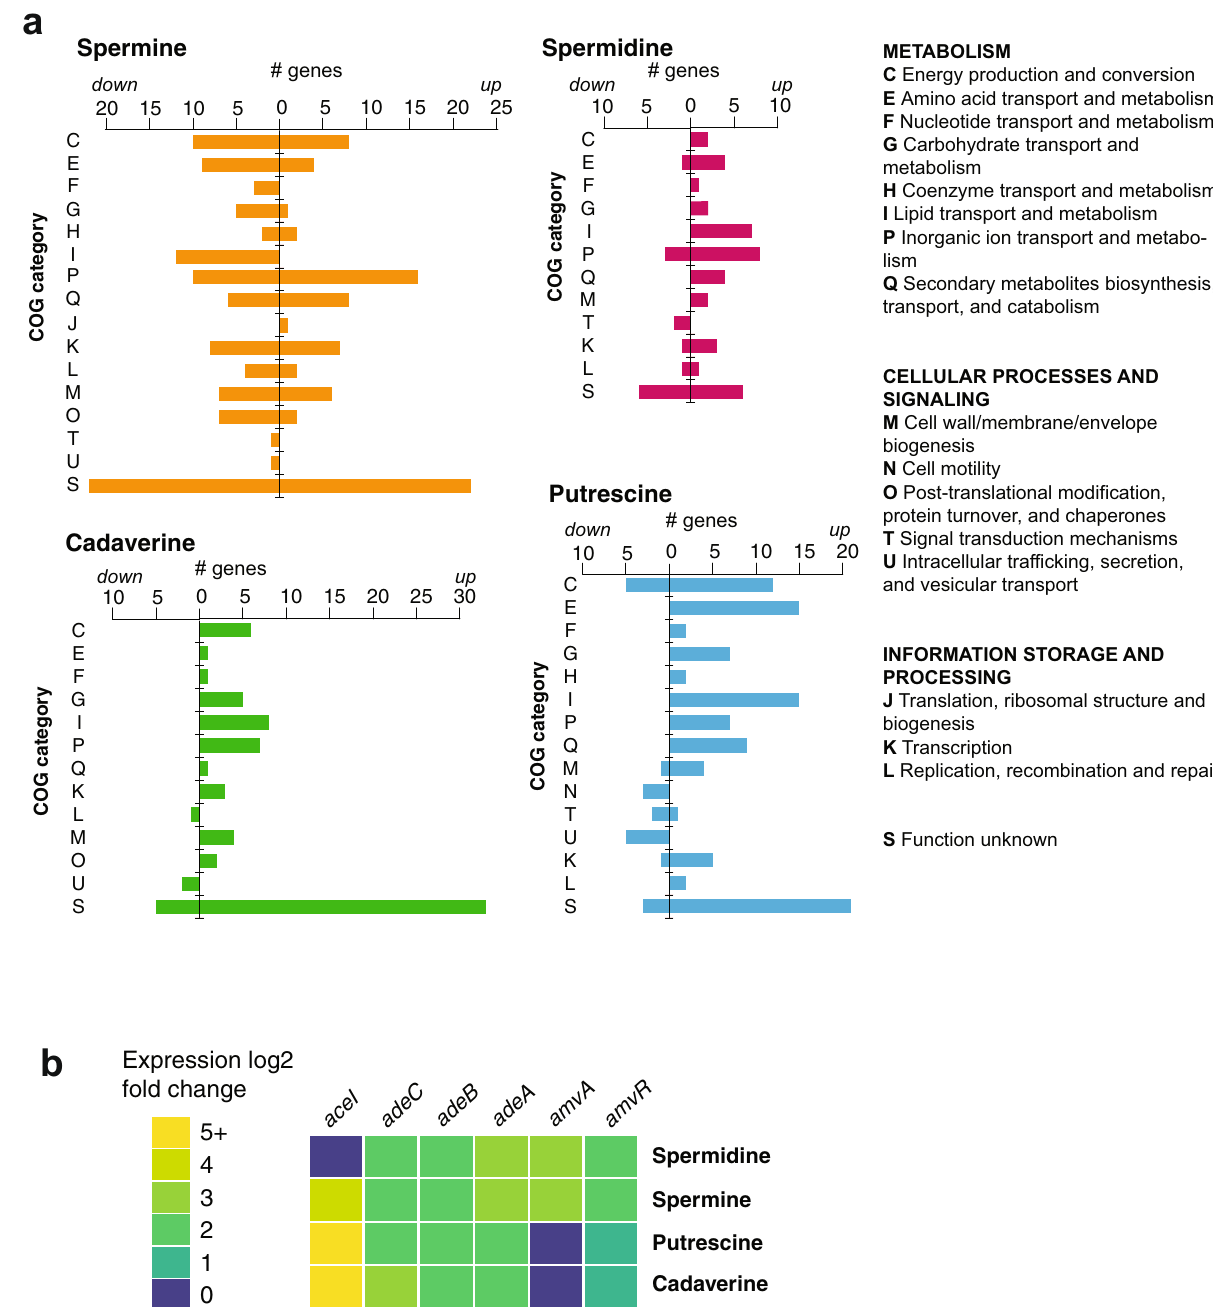
Fig. 2 Polyamine-regulated gene functional categories and phenotypes. a Functional categories of genes regulated by spermine, spermidine, putrescine and cadaverine. COG categories of the genes showing expression changes in response to each molecule are shown. Regulated genes came from multiple functional classes, and lipid/inorganic ion transport and metabolism genes were highly represented. b Discontinuous heatmap showing induction of the ef fl ux pump genes aceI (PACE family), adeABC (RND family) and amvA (MFS family) and its regulator amvR by different